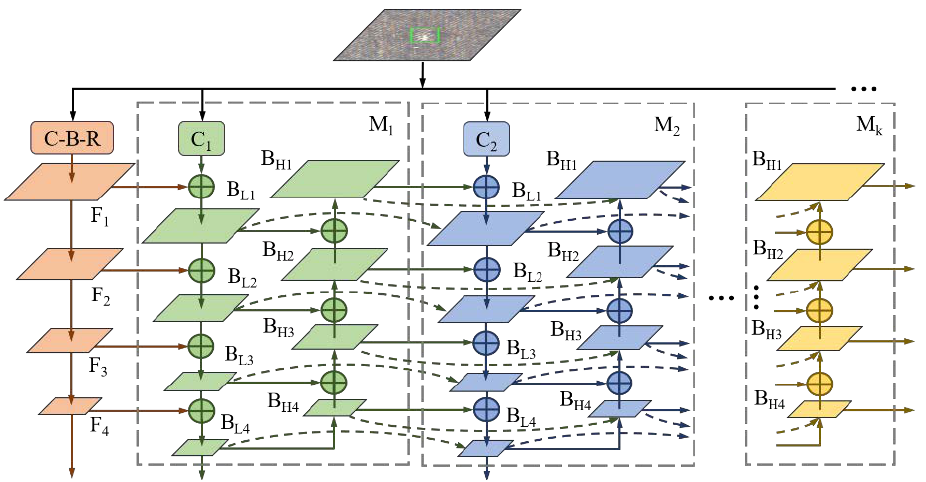
Figure 5. Composite interpolating feature pyramid (CI-FPN).